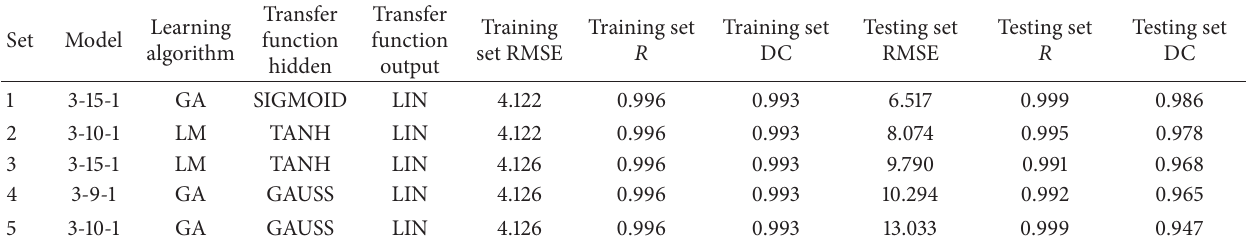
Figure 1: Surface response plots of (a, b, c) biomass concentration, (d, e, f) intracellular lipid, and (g, h, i) overall lipid productivity as modeled via RSM. Table 4: The effect of different full feed-forward network architectures on the model residual error (RMSE, 𝑅 , and DC) in the prediction of lipid productivity from mixotrophic Tetraselmis